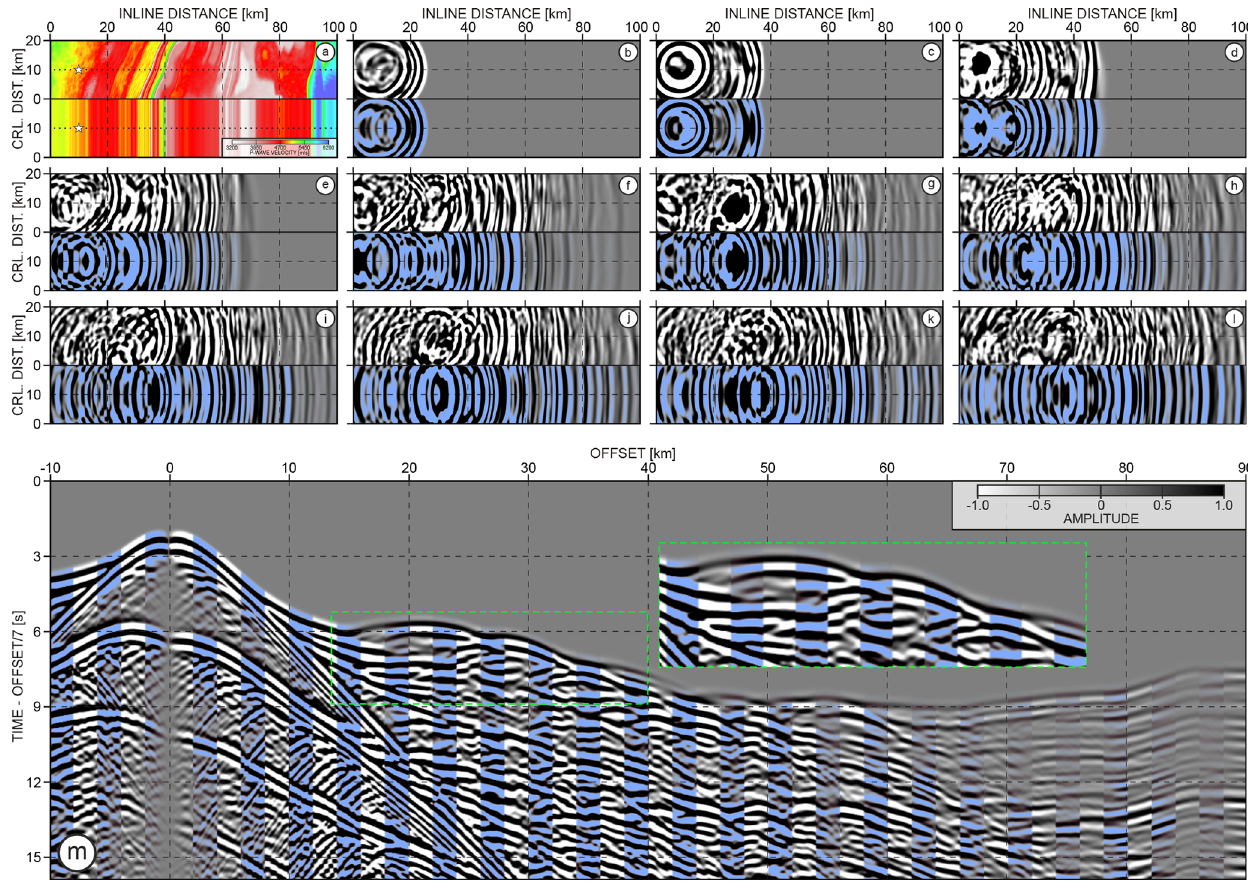
Figure 12. (a) Depth-slice sections extracted at 10km depth from 3D (upper half) and 2.5D (lower half) V p sub-volumes. White stars and black dotted lines mark the projection of the OBS position and shooting profile respectively; (b–l) snapshots extracted during wavefield modelling at each 2.5s time step along the corresponding depth slices from (a) . (m) Analogous comparison between 2.5D and 3D data as in Fig. 11c. Amplitudes are scaled with the absolute offset